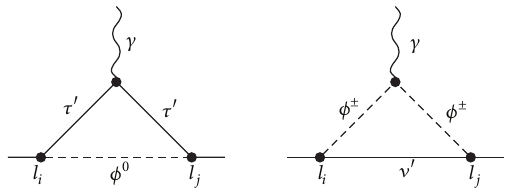
Figure 12: One-loop diagrams for 𝑙 𝑖 → 𝑙 𝑗 𝛾 with charged and neutral scalar